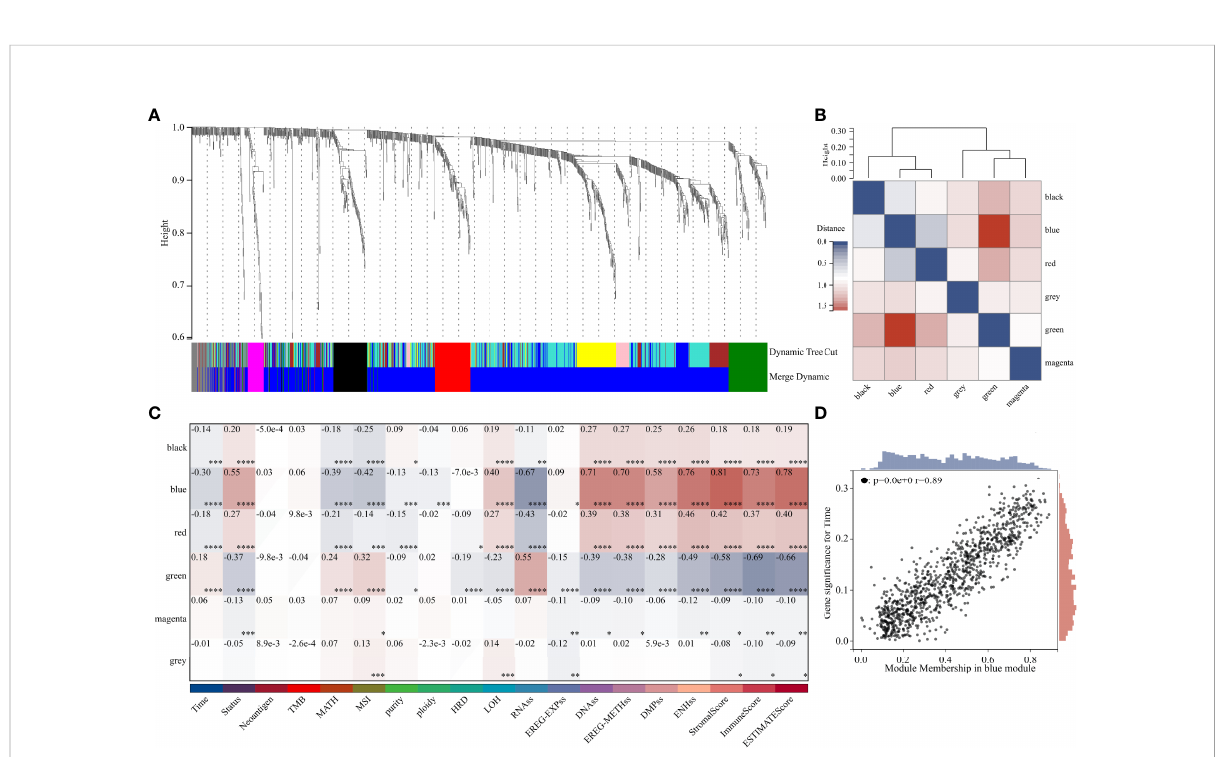
FIGURE 8 Weighted Correlation Network Analysis. (A) Clustering of module genes in the TCGA cohort. (B) Cluster dendrogram of modules. (C) Module- trait relationships. (D) Scatter plot of correlation between GS and MM. *, P < 0.05; **, P < 0.01; ***, P < 0.001; ****, P <